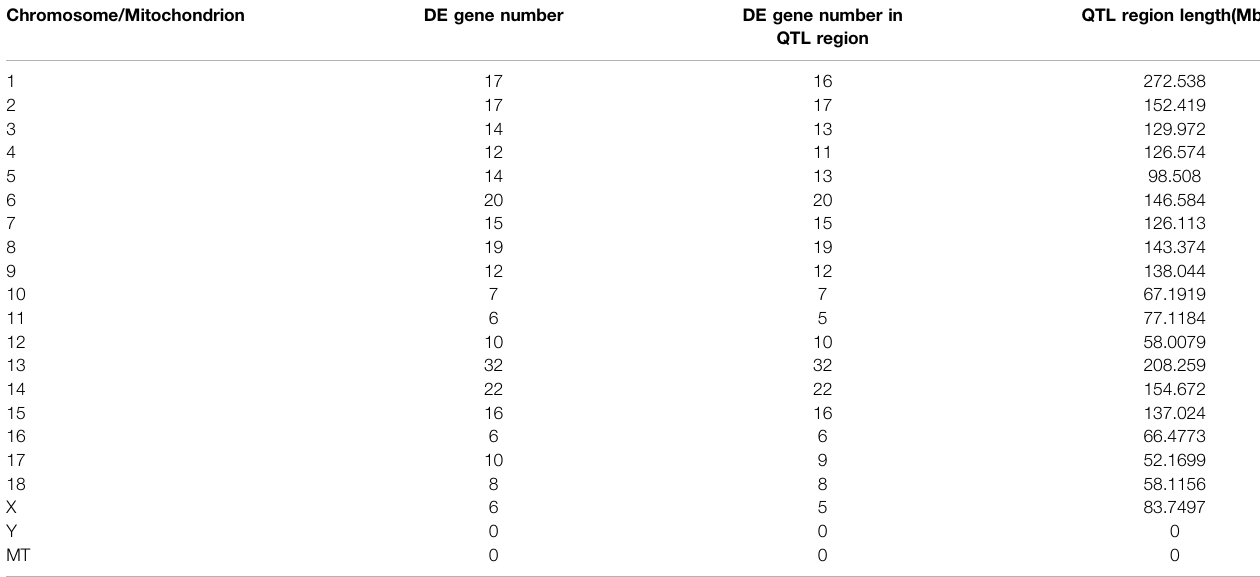
TABLE 3 | Target gene of DE circRNAs distribution in chromosome and QTLs region.